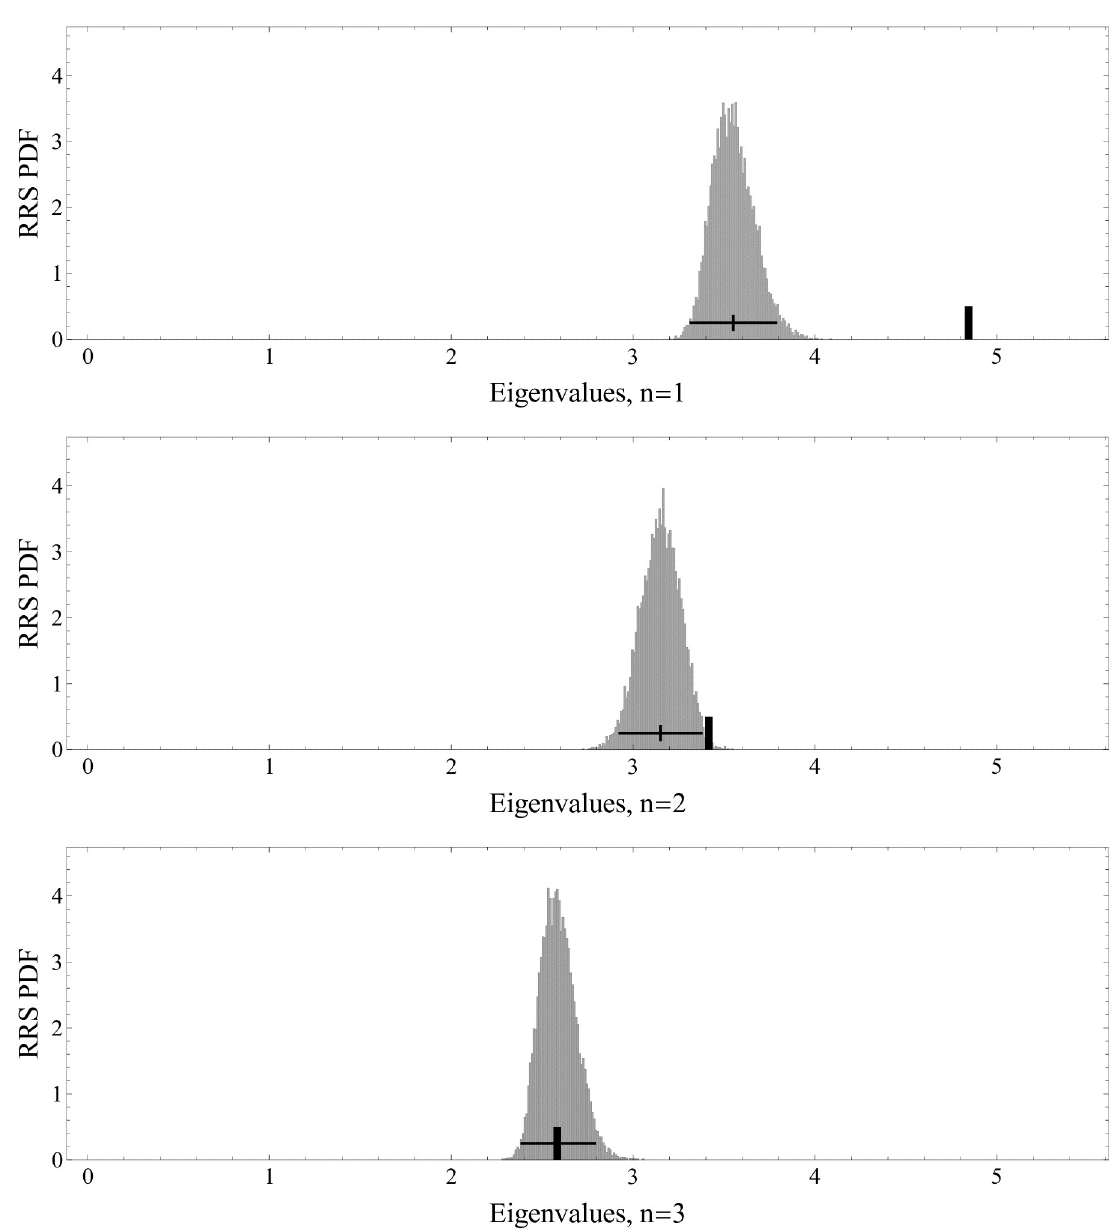
Fig 5. The top three eigenvalues and the corresponding RRS eigenvalue distributions. The eigenvalues are shown with thick ticks and the RRS eigenvalue distributions are shown with shaded bell-shaped curves. Horizontal bars show the 2 σ ranges. The eigenvalues #1 and #2 are above the RRS 2 σ range and, therefore, are significant. The eigenvalues #3 and below are not. The top and the second eigenvector components are shown in Fig 6, where each compo- nent is shown by a marker specified by the product code at its top and the style shown in the legend. (The details of these eigenmodes are given in the S1 File) The horizontal axis is its phase, and the vertical axis its absolute value. The arbitrary overall phase in the eigenvector e is chosen so that the components representing purchase quantities are toward the right-hand side of the plots. By the definition of the complexification, the phase corresponds to the time- variation; the components on the left move first, and the components to the right follow. We